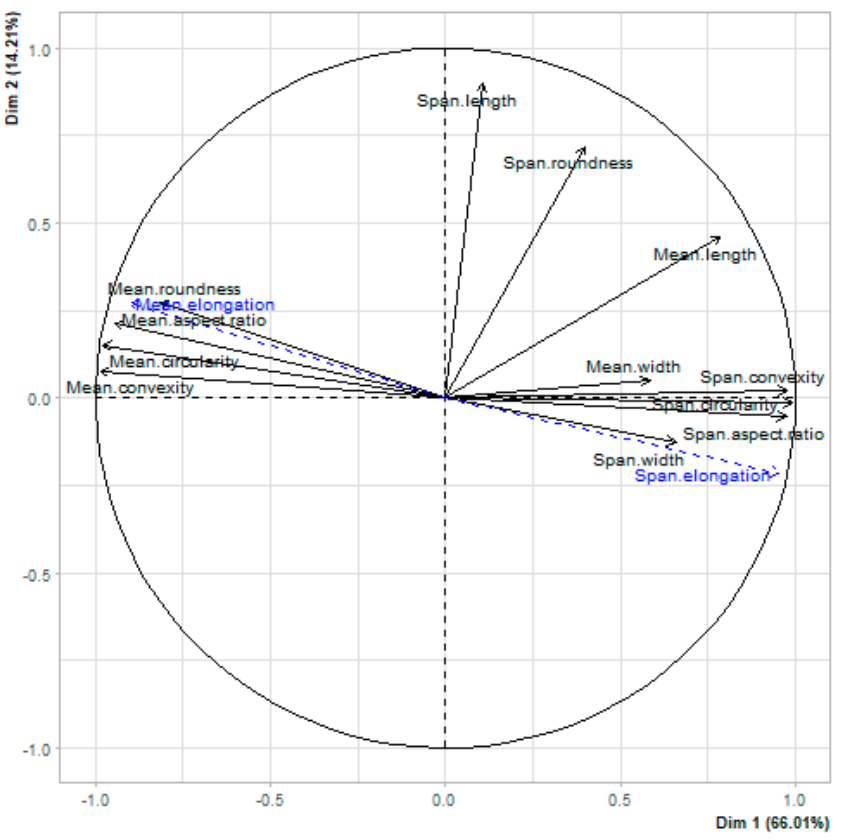
Figure 4. PCA correlation circle for variables describing particle size, shape, and diversity.